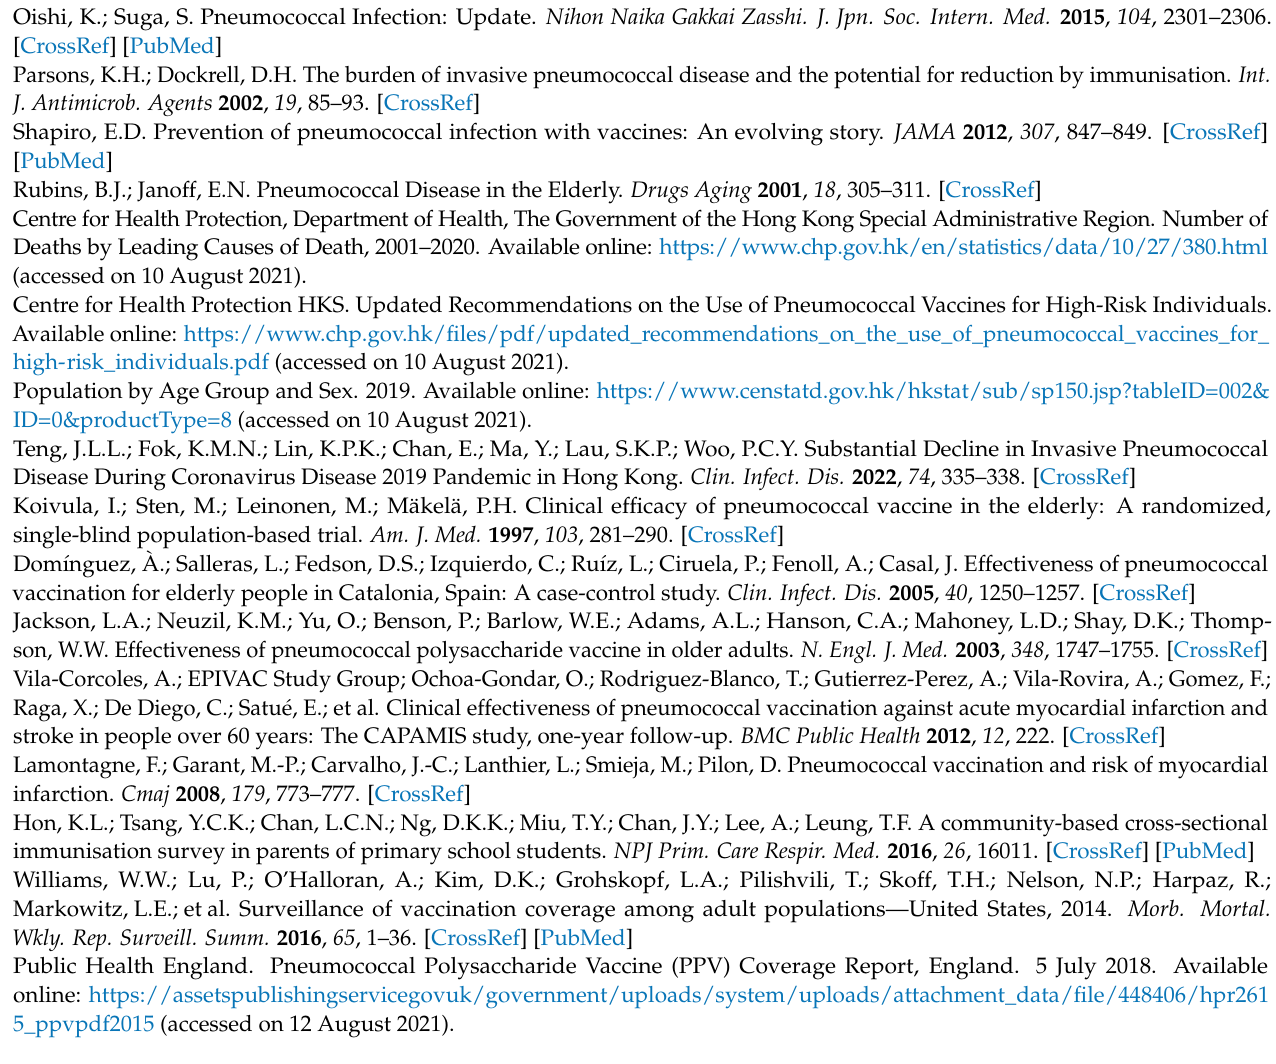
Framework. Table S1: Number of codes by theme among service providers. Table S2: Number of codes by theme among